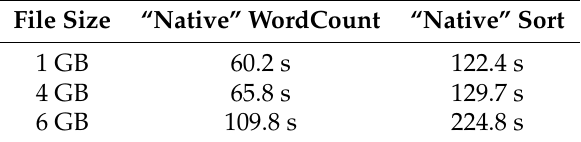
Table 1. Execution times for WordCount and Sort jobs in the Native Environment.